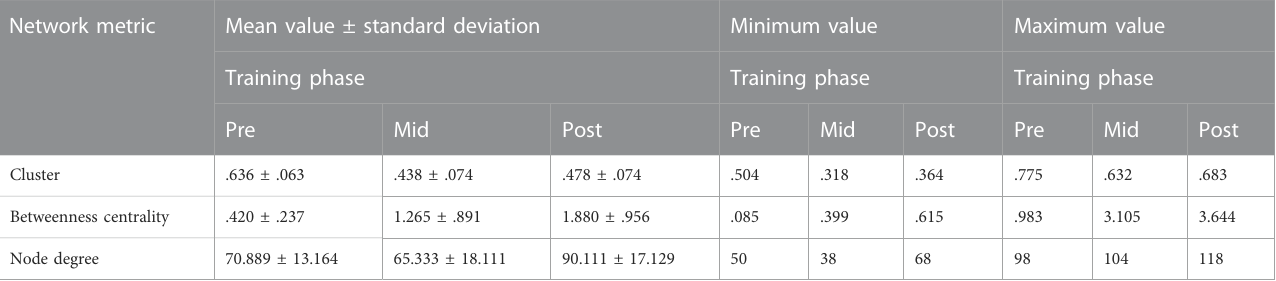
TABLE2Descriptivestatisticsfortherightpostcentralgyrus,where “ pre ” standsforbeforeSAHC, “ mid ” standsforSAHCaloneinbothprotocols,and “ post ” standsfor SAHC combined with exercise. Network